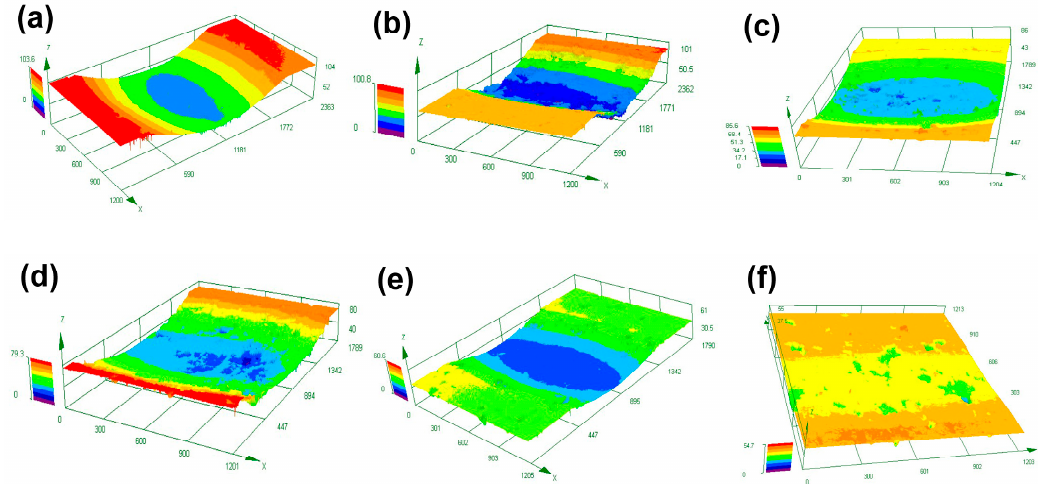
Figure 7. 3D morphologies of wear marks of ( a ) the Fe 65 P 5 Si 9 B 10 coating at 100 N; ( b ) the Fe 65 P 5 Si 9 B 10 Cr 10 coating at 100 N; and ( c ) the Fe 65 P 5 Si 9 B 10 Cr 10 Nb 1 coating at 100 N; ( d ) the Fe 65 P 5 Si 9 B 10 coating at 45 mm·s − 1 ; ( e ) the Fe 65 P 5 Si 9 B 10 Cr 10 coating at 45 mm·s − 1 ; and ( f ) the Fe 65 P 5 Si 9 B 10 Cr 10 Nb 1 coating at 45 mm·s − 1 .